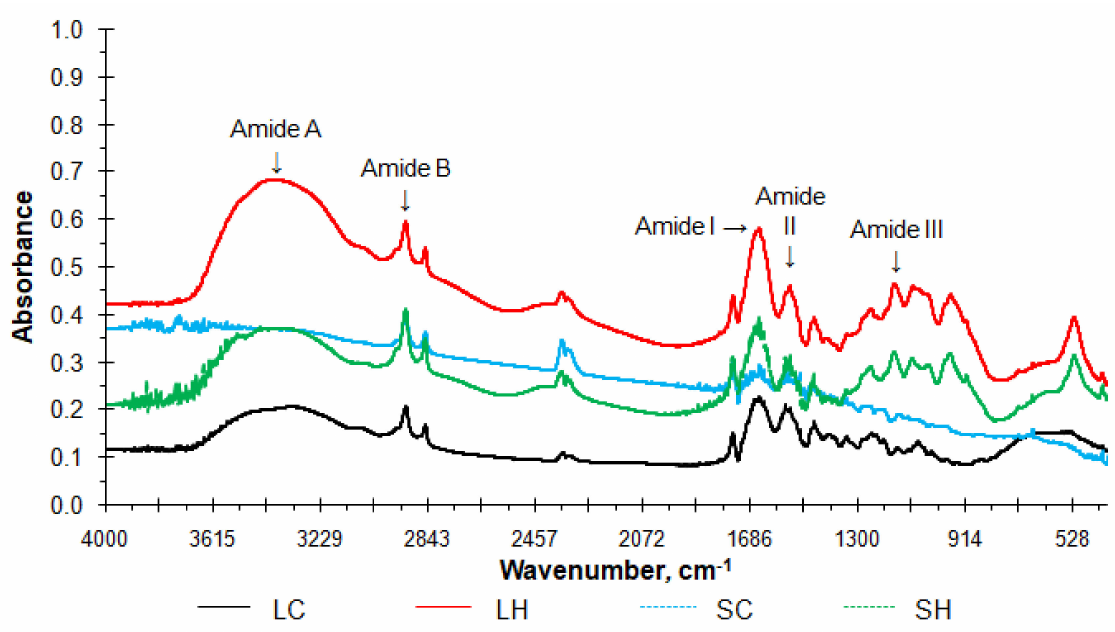
Figure 1. FTIR spectra of collagens and hydrolysates from sheep slaughter by − products (LC − lamb collagen; SC − sheep collagen; LH − lamb hydrolysate; SH − sheep